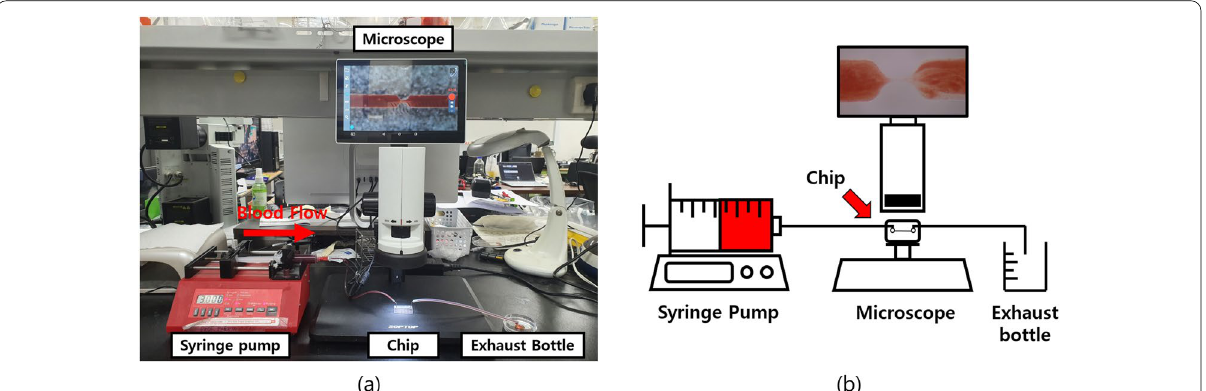
Fig. 2 Setup for observation of thrombogenesis in an in vitro thrombus chip. ( a ) Image of the setup. ( b ) Schematic diagram of the setup